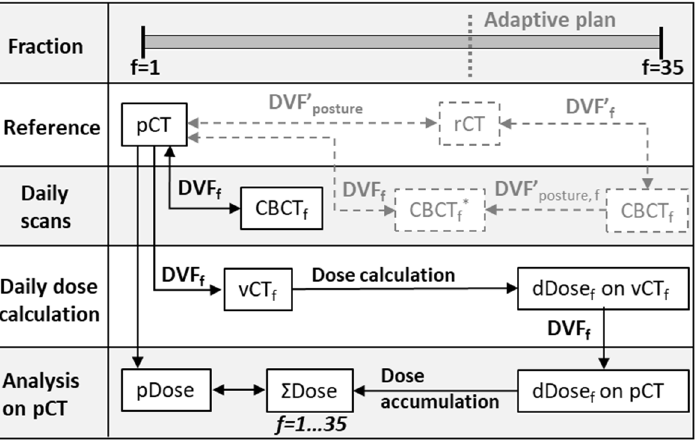
Figure 1. Schematic overview of workflow to calculate the daily delivered dose.